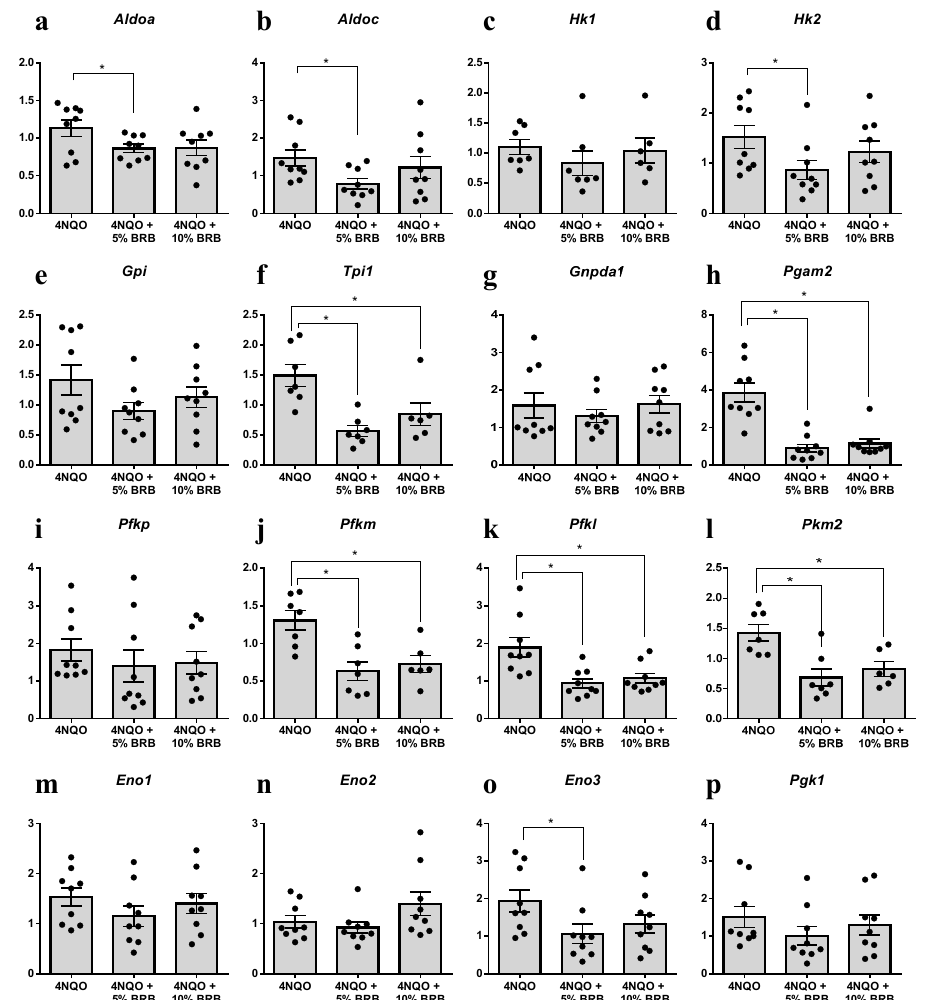
Figure 3. Modulation of the glycolytic pathway by dietary BRB during oral carcinogenesis. ( a – p ) gene expression profiles of the glycolysis pathway genes in rat tongue RNA from 4NQO-exposed rats fed the control diet (4NQO), 5% BRB supplemented diet (4NQO + 5% BRB), or 10% BRB supplemented diet (4NQO + 10% BRB), as determined by RT-qPCR. (* p < 0.05) .